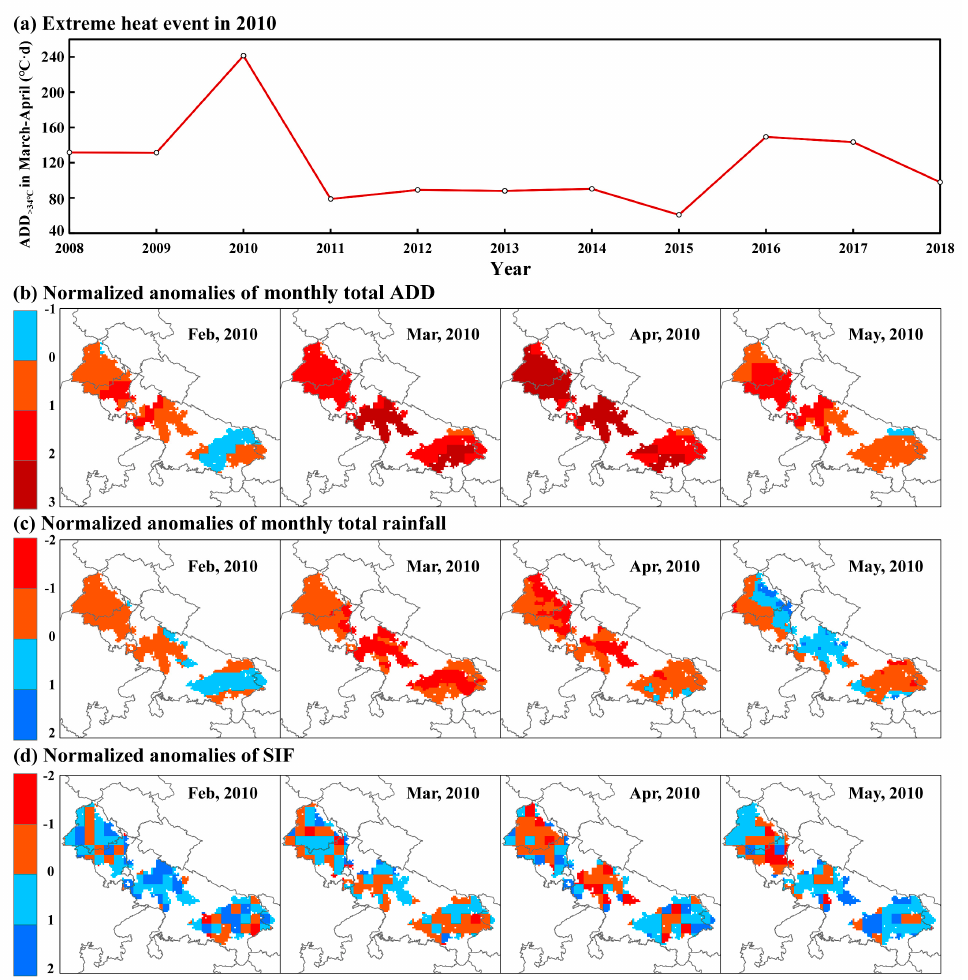
Figure 6. The 2010 extreme heat event in the IGP. ( a ) Interannual variations of ADD > 34 ◦ C in March–April. Spatial distribution of ( b ) normalized anomalies of the total ADD, ( c ) normalized anomalies of monthly average rainfall, ( d ) and normalized anomalies of SIF from February to May in 2010.